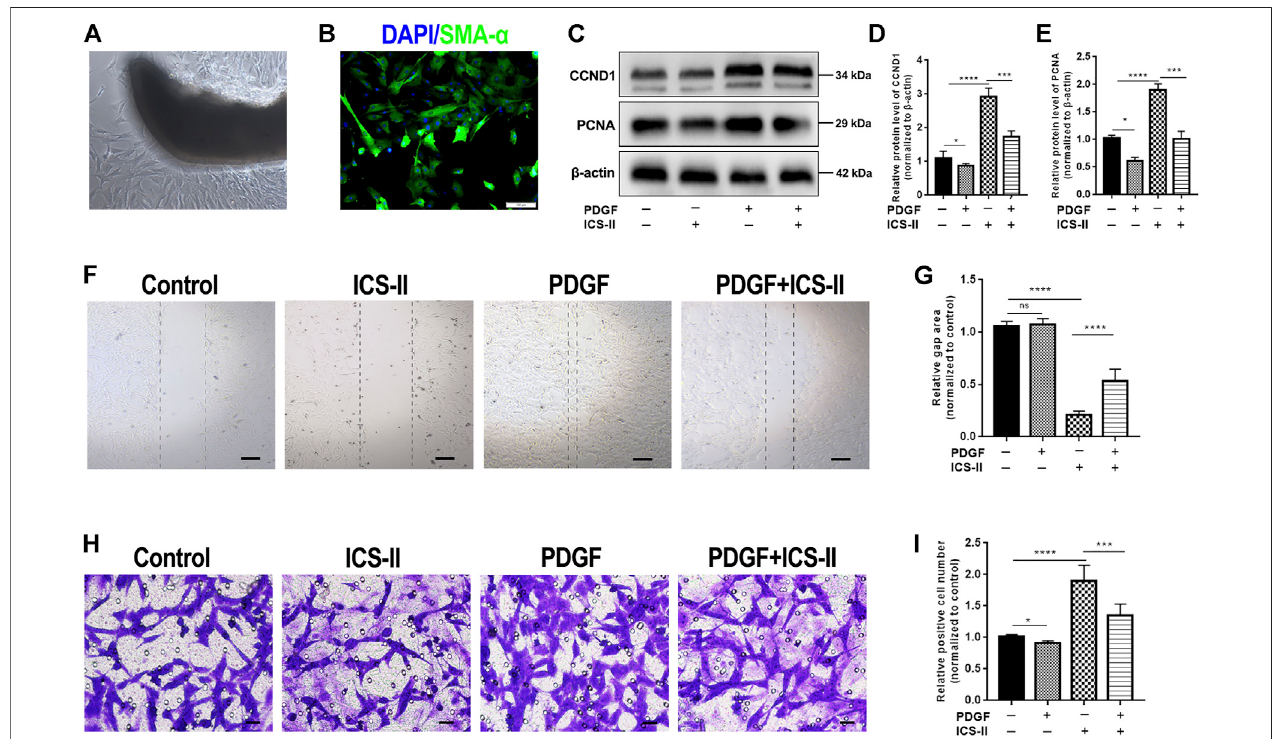
FIGURE4| ICS-IIinhibitedVSMCproliferationandmigration. (A) VSMCswereprimarilyculturedbyusingtheexplantmethod. (B) Veri fi cationofVSMCsatpassage 3withSMA- α (green)andDAPI(blue)staining. (C) WesternblotimagesforPCNAandCCND1.Quanti fi cationof (D) CCND1and (E) PCNAproteinlevels,respectively. (F) In vitro scratchassayforcontrol, ICS-IIand PDGF-BB, andPDGF-BB +ICS-II groups, respectively. (G) Quanti fi cation ofthegap areainthescratchassay. (H) Transwell migration assay for control, ICS-II, and PDGF-BB and PDGF-BB + ICS-II groups, respectively. (I) Quanti fi cation of migrated cell number in the transwell assay. Scale bar = 20 μ m; Data are presented as mean ± S.E.M. N = 5 per group. * p < 0.05, ** p < 0.01, *** p < 0.001, **** p <